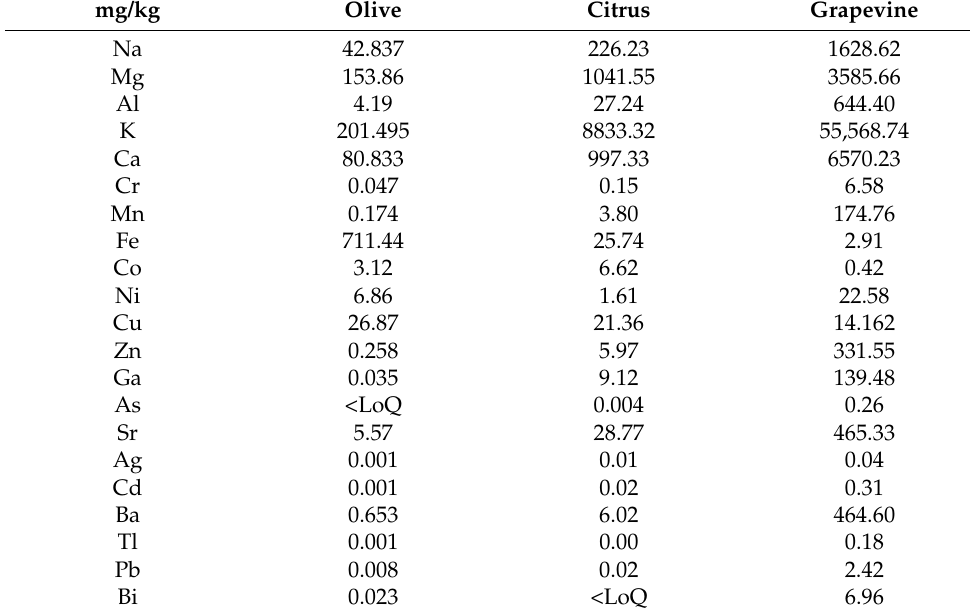
Table 4. Metals concentration in